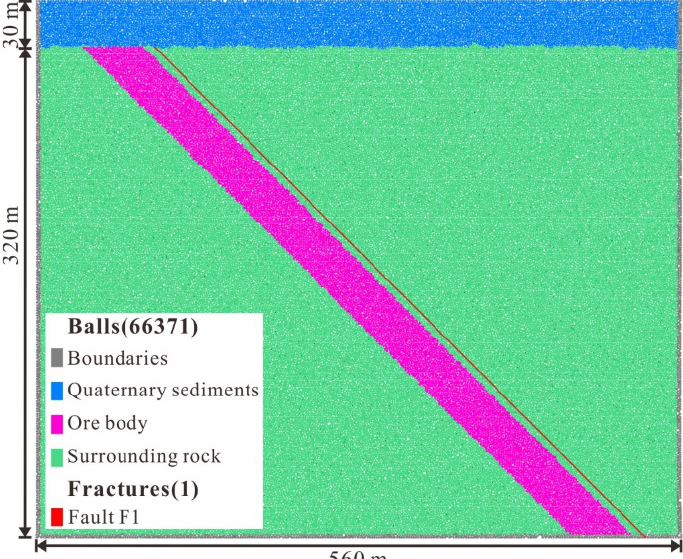
Figure 6. The numerical simulation model. Table 4. Microscopic parameters in